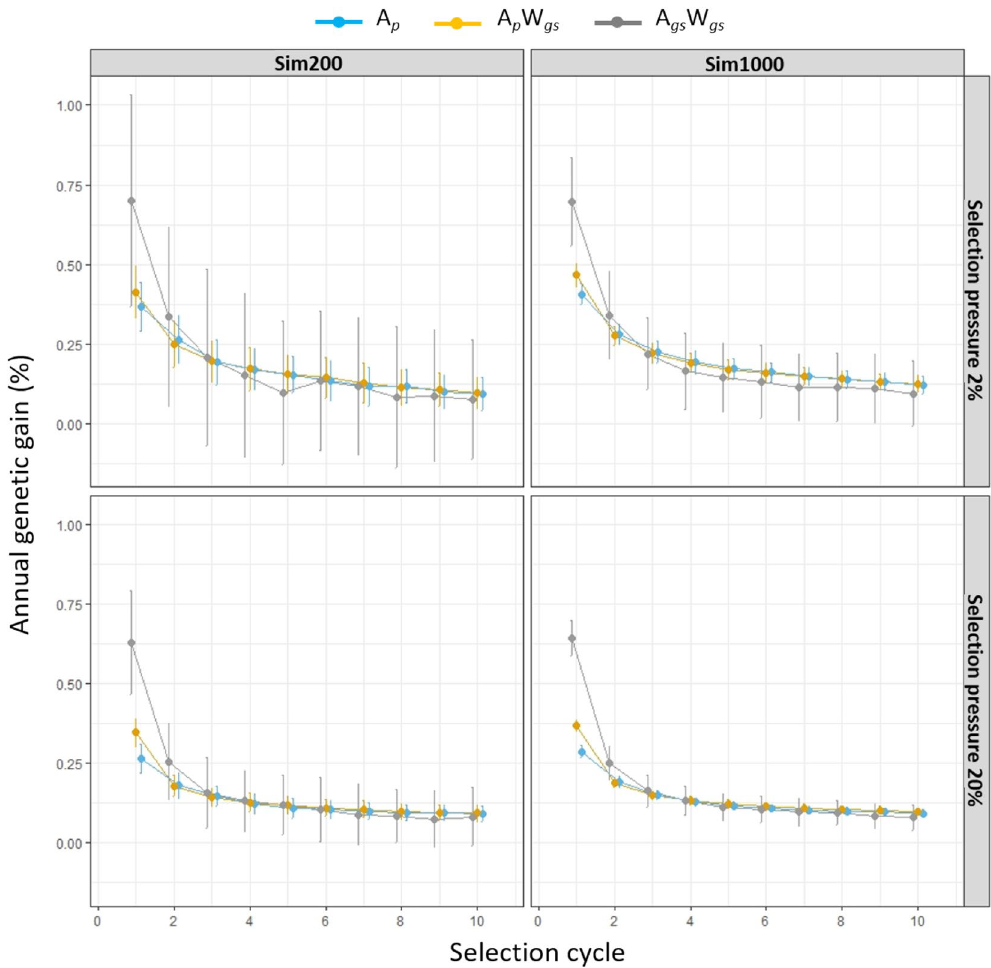
Figure 2. The percentage genetic gain (%ΔG) per year for DM yield in Sim200 and Sim1000 training populations estimated across 10 selection cycles using three breeding strategies (A p , A p W gs and A gs W gs ). Selection pressures of 20% and 2% were imposed to select the best HS families. Within each family, for the A p W gs and A gs W gs strategies the top 5 or 50 individuals were selected and for the A p strategy 5 or 50 individuals were randomly selected to restore the initial number of parents for the next selection cycle. In each selection cycle %ΔG was based on 250